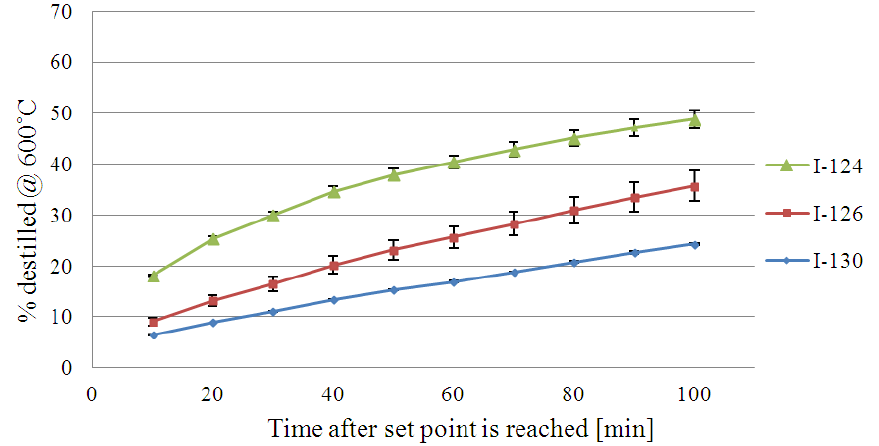
Figure 5. Graph showing the percentage of the individual iodine isotopes, distilled as a function of time at 600 °C. It is seen that the isotopes do not distil out at the same proportionate rate. At temperatures above melting point this effect almost completely disappears.